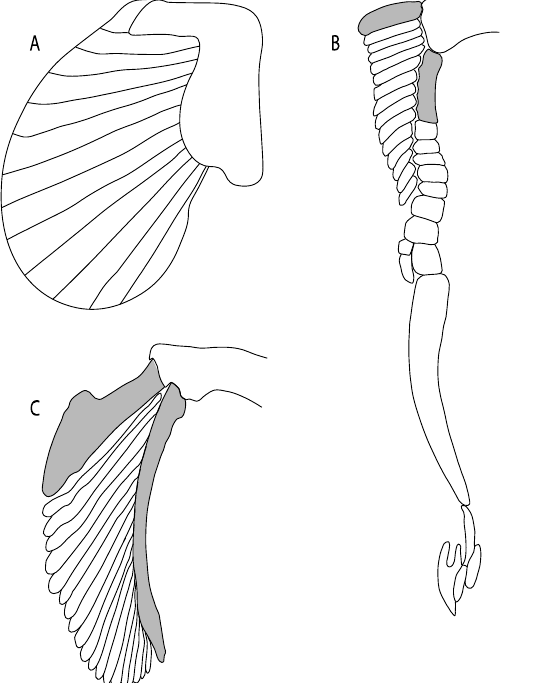
Figure 48. Interpretative drawings of the pelvic fins and girdles in dorsal view. State (0) ( A ) Chimaera cubana (USNM 400700, https://sharksrays.org/ (accessed on 25 March 2020)). ( B ) † Hybodus hauffianus based on Maisey Text-Figure 13A in [57]. State (1) ( C ) Zapteryx exasperta (CNPE-IBUNAM 20528). Basipterygium and first pelvic radial in gray.